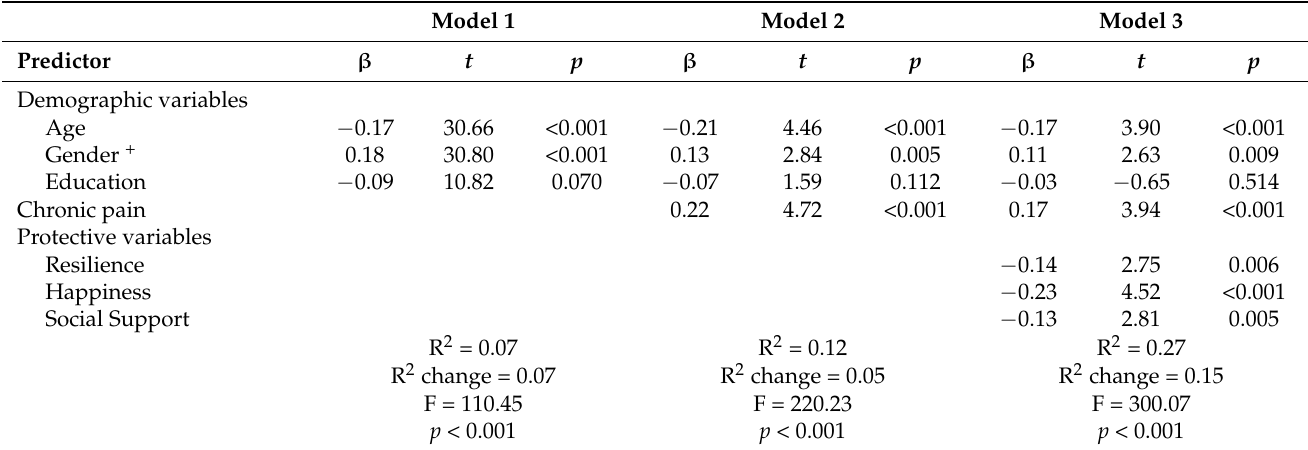
Table 4. Regression analyses predicting